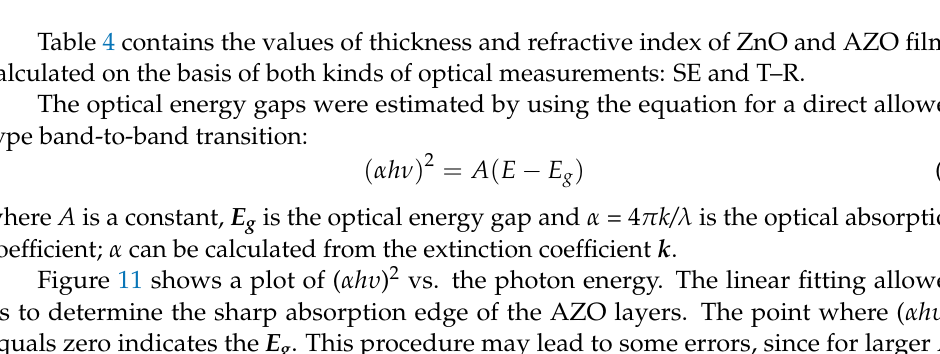
Figure 10. The spectral dependences of: ( a ) the refractive index n and ( b ) the extinction coefficient k , obtained by the use of the Cauchy model.